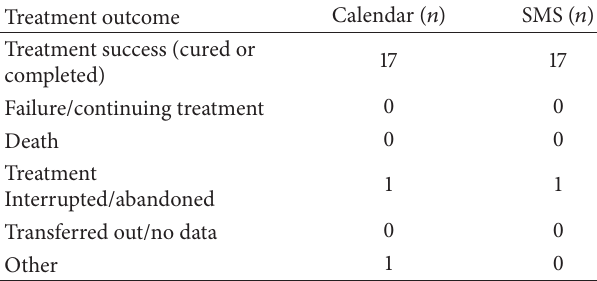
Table 5: Treatment outcomes by